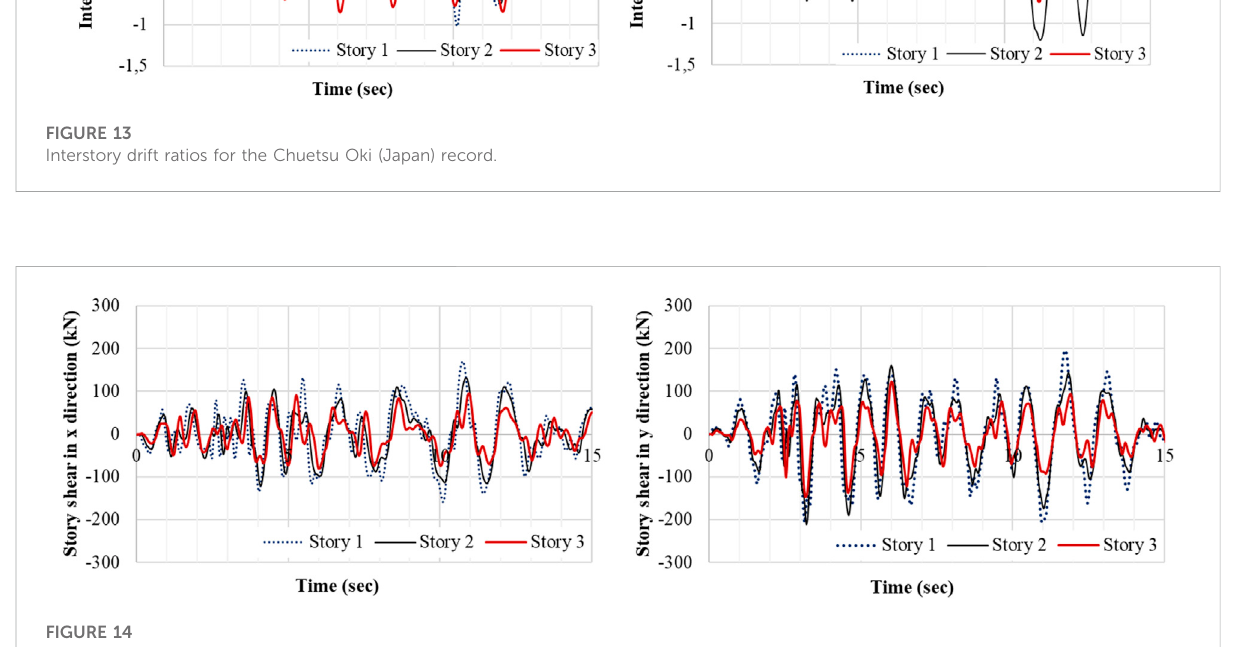
FIGURE 14 Base shear – time history